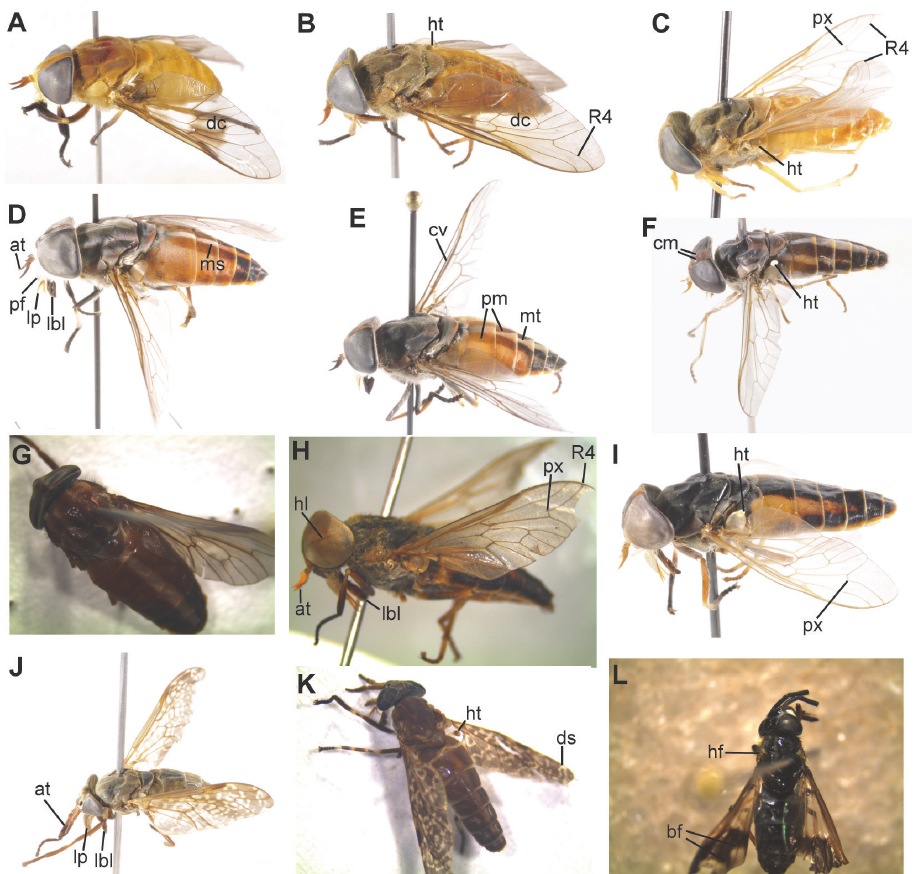
Figure 3. Whole tabanid flies. A Ancala fasciata, discal cell (dc) B Tabanus thoracinus, discal cell (dc), haltare (ht) C Tabanus donaldsoni, distinct R4 appendix (px) D Tabanus taeniola, median stripe (ms), parafacial hair (pf), antennae (at), labellum (lbl), palpus (lp) E Tabanus taeniola variatus, medial triangles (mt), peri-median bands (pm) F Tabanus gratus, haltares (ht), comma shaped shades (cm) G Tabanus guineensis H Atylotus nigromaculatus, eyes with thin black horizontal line (hl) I Atylotus diurnus, haltares (ht), wing with indistinct appendix (px) J Haematopota duttoni K Haematopota fenestralis , double white streak (ds) L Chrysops distinctipennis, hair tufts (hf), bifurcating band (bf).